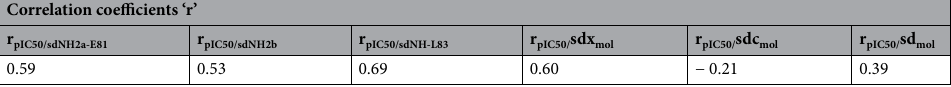
Table 3. Correlation coefficients ‘r’ calculated between pIC50s and hydrogen-bond donor strengths for the individual hydrogens (NH2a-E81, NH2b, NH-L83) and the molecule by accounting for only X–H (sdx mol ), only C–H (sdc mol ), or both (sd mol ). The formula used for the calculation of ‘r’ is reported in the Supplementary